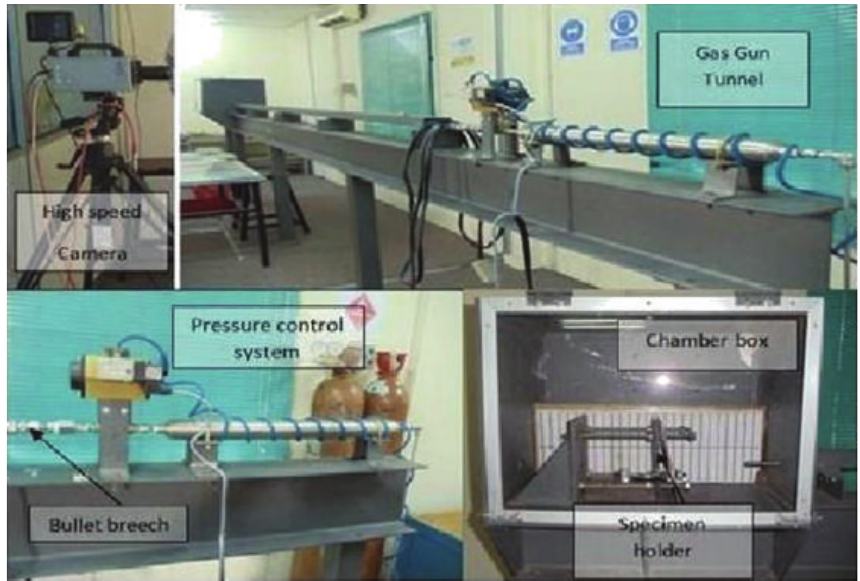
Figure 3: Gas gun tunnel for conducting the ballistic impact test [12]. D = 8.48 mm